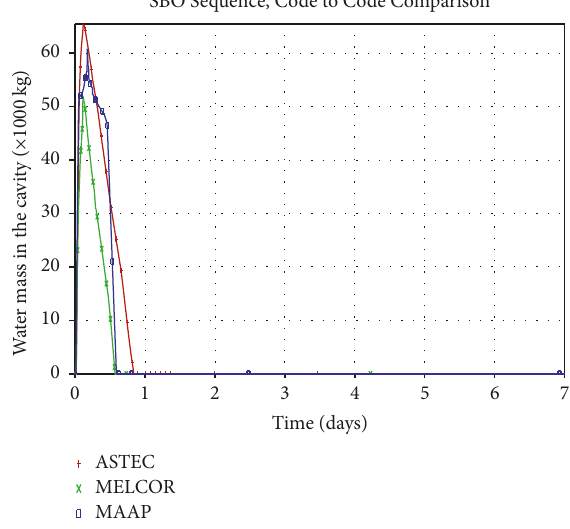
Figure 9: Mass of water in the reactor